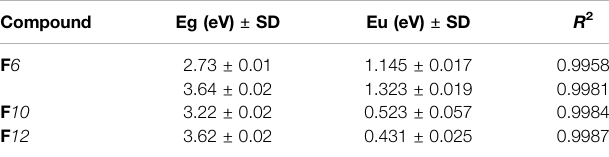
TABLE 2 | Values of the energy gap, Eg, and Urbach energy, E U , of F 6 , F 10 , and F 12 .